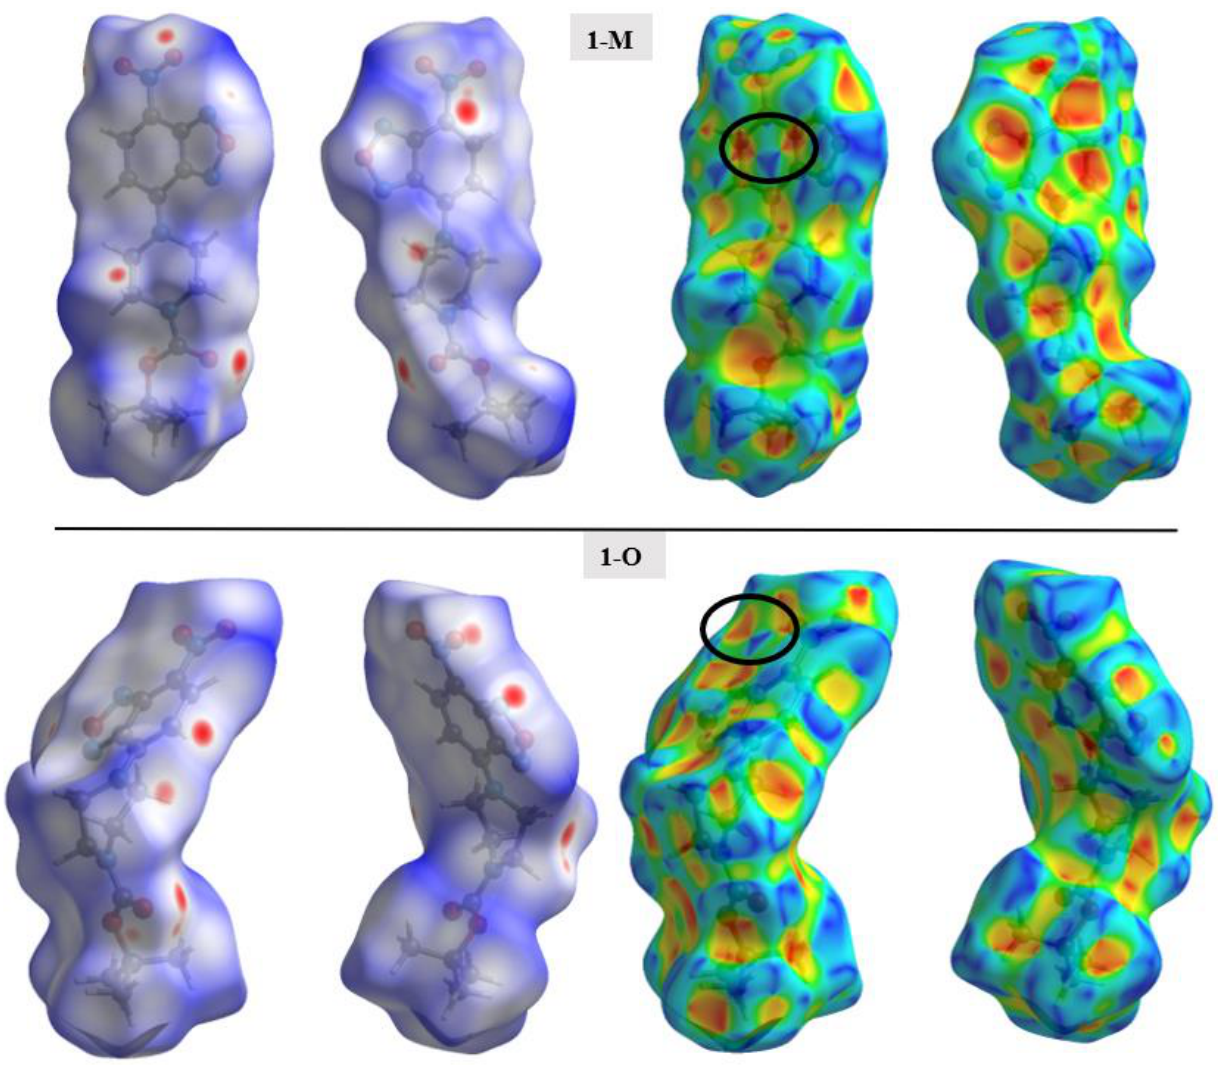
Figure 5. The Hirshfeld surface mapped with d norm ( left ) and the shape index ( right ) for both polymorphs. Two orientations of each surface are shown to help visualize the complete surface. Black circles are used to draw attention to characteristic patterns indicative of π - π stacking.